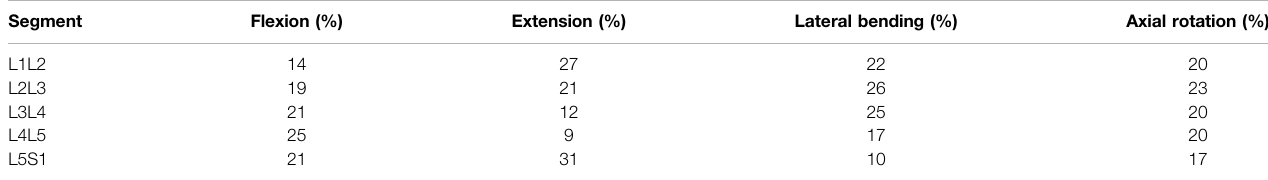
TABLE 1 | Mean values of segment contribution to overall lumbar range of motion in fl exion, extension, lateral bending, and axial rotation. The mean values of several in-vivo measurements are shown and were obtained from Widmer et al. (2019). Segment